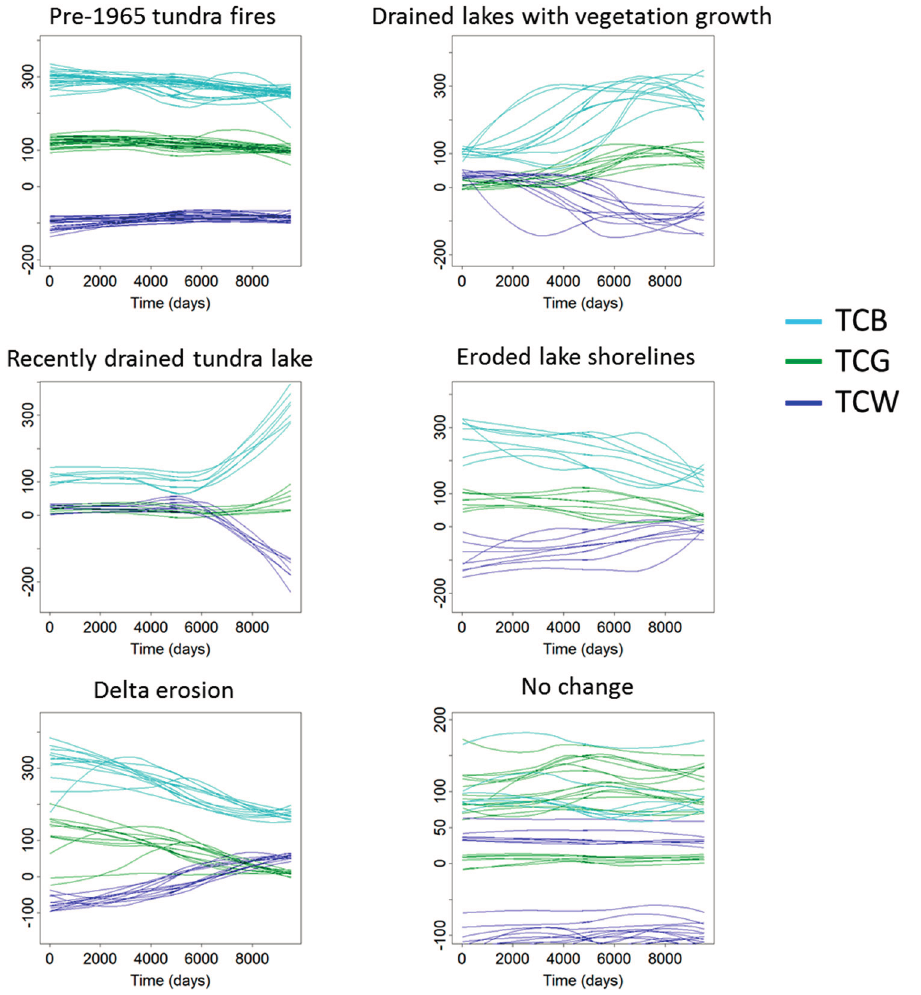
Figure 4. Examples of changes with relatively consistent Tasseled Cap temporal profiles (left column) and inconsistent profiles due to temporal misalignment or the nature of change itself (right column).